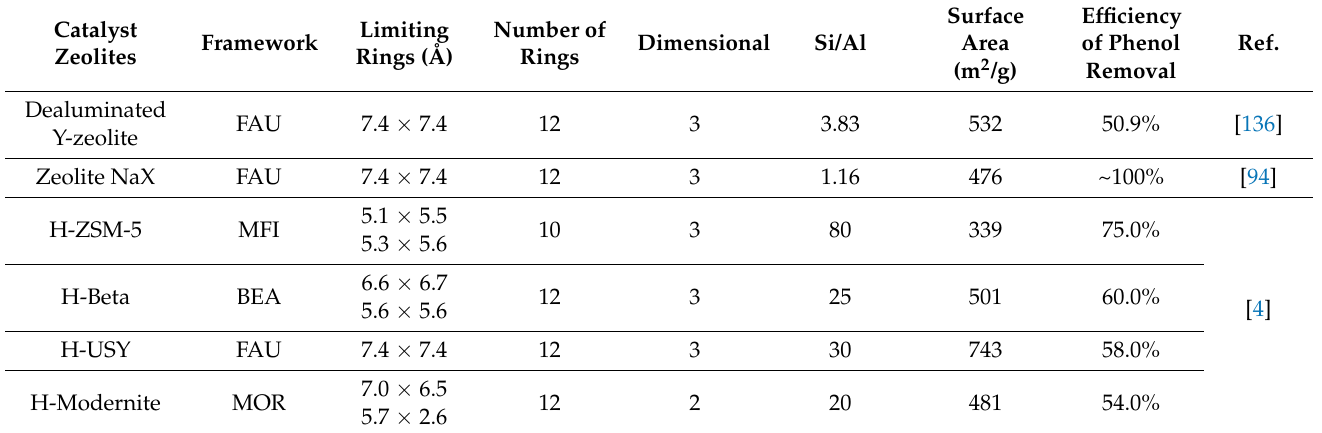
Table 16. Comparison of zeolite characteristics on phenol removal efficiency using catalytic ozonation process. Catalyst Zeolites